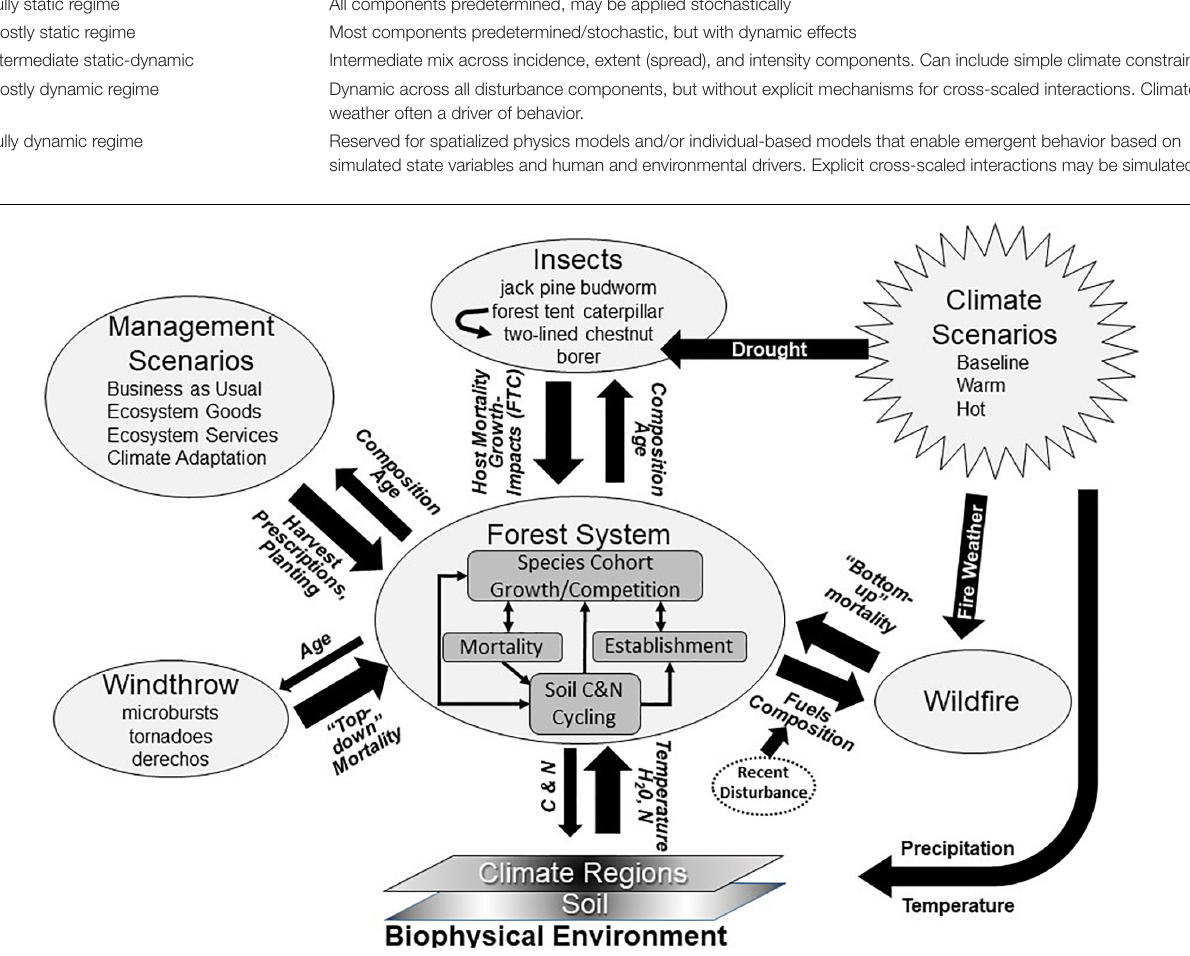
FIGURE 8 | Example modeling study investigating multiple disturbance interactions, where disturbance interactions are primarily indirect via site-level state variables such as composition, age structure, and fuel loading. Climate drivers directly affect just small subsets of disturbances directly, but indirectly affect state variables that can lead to emergent system behavior as a function of two scenario factors (i.e., climate and management). (Adapted from Lucash et al.,